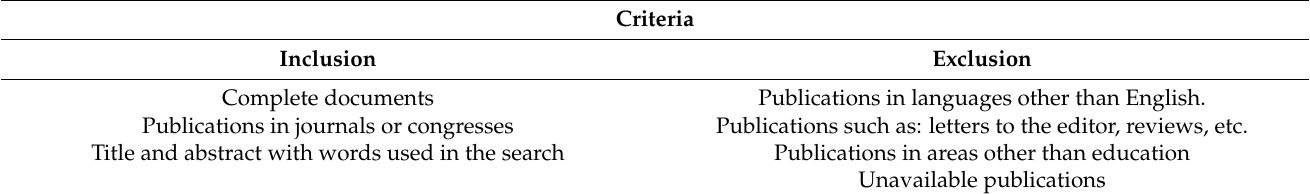
Table 3. Inclusion and exclusion criteria.